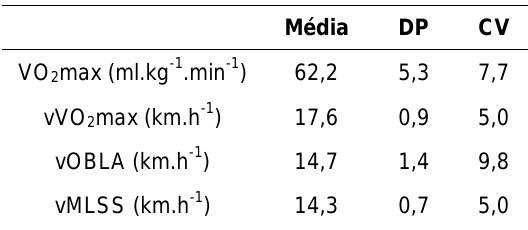
Tabela 1. Valores descritivos das variáveis fisiológicas dos atletas.